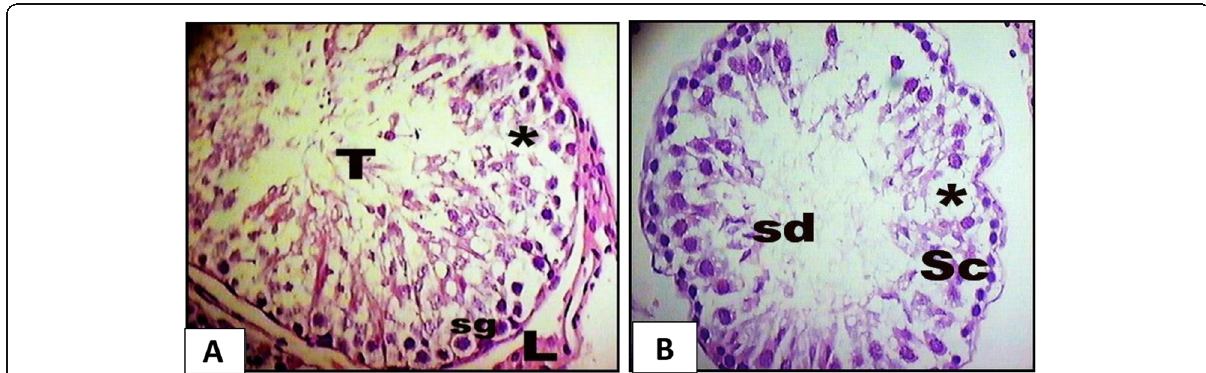
Fig. 2 a A photomicrograph of C.S. of testis from the group (III) showing moderate spermatogenic arrest (*), few spermatogonia (sg), decreased in number of sperms (T) and spermatids in the seminiferous tubule, and interstitial spaces with Ledge cells (L) H&E (× 400). b A photomicrograph of C.S. from the group (IV) rat testis showing disorganized irregular outline seminiferous tubule, disruption of the epithelial lining of the tubules, and impaired arrested spermatogenesis (Sc); detached germ cells, spermatogonia, and deteriorated spermatids (sd); degeneration of spermatogenic elements with appearance of vacuoles (*); and reduction of sperm in the lumen and rarity of Leydig cells. H&E (×